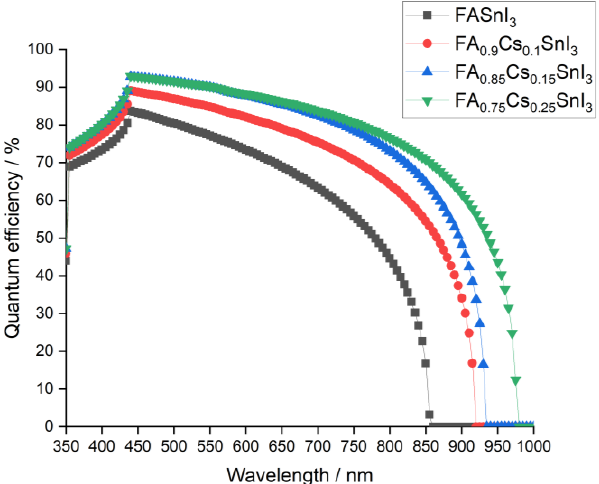
Figure 5. Quantum efficiency of the simulated device with ZnOS ETL and different Cs content.